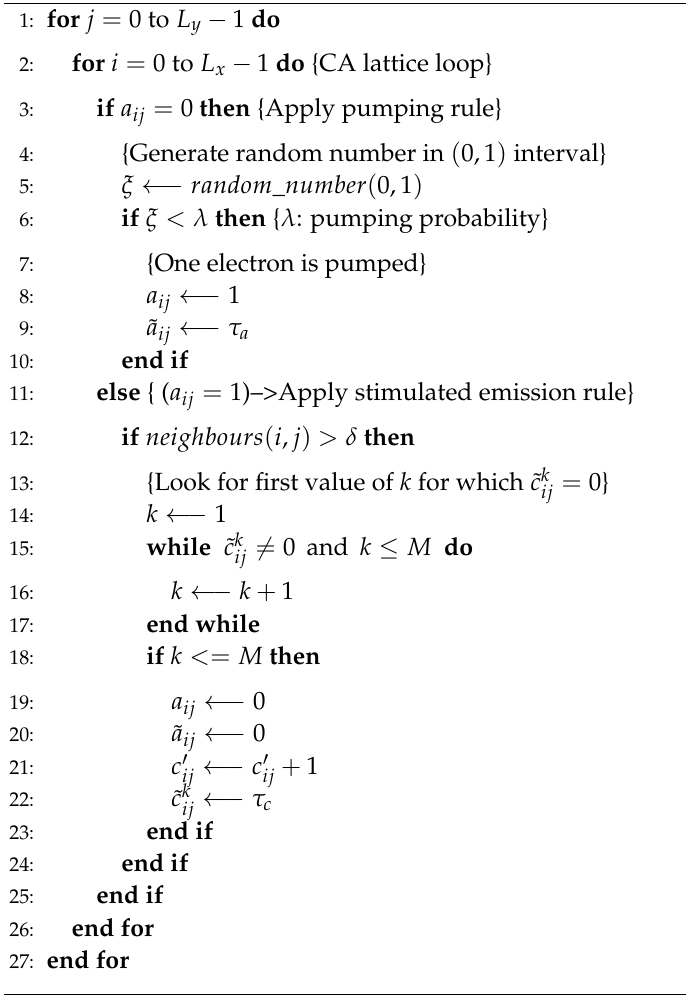
Algorithm 4 Pseudo code diagram for the implementation of the pumping and stimulated emission